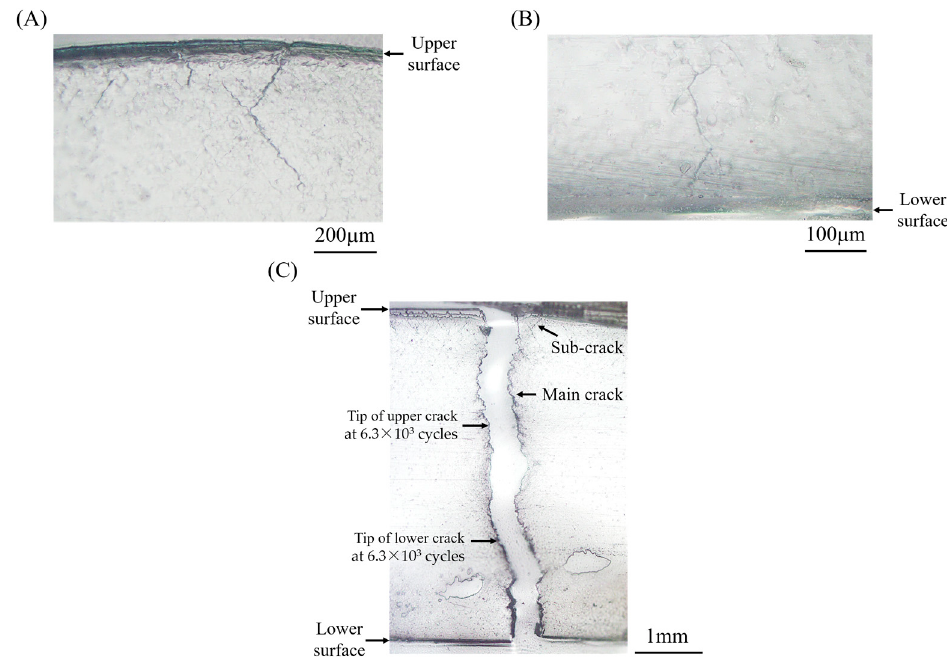
Figure 6. Crack profiles (bending specimen, t = 5 mm, ∆ ε t = 0.015, and N f = 6.5 × 10 3 cycles): ( A ) crack propagation from upper surface, N/N f = 0.87, ( B ) crack propagation from lower surface, N/N f = 0.87, and ( C ) final fracture due to coalescence of cracks propagating from upper and lower surfaces.